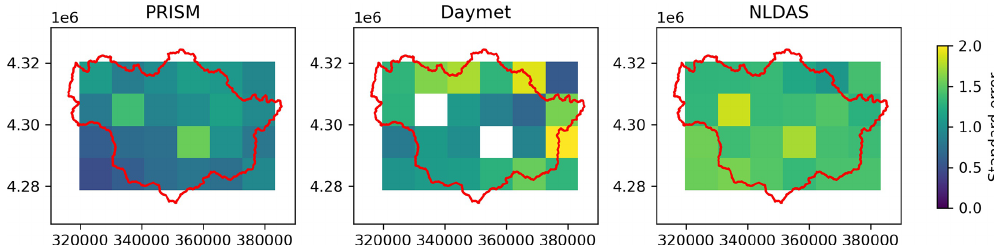
Figure A2. TCA results for temperature data in the three GMFs. The color map shows the standard error (the lower the better) for each pixel